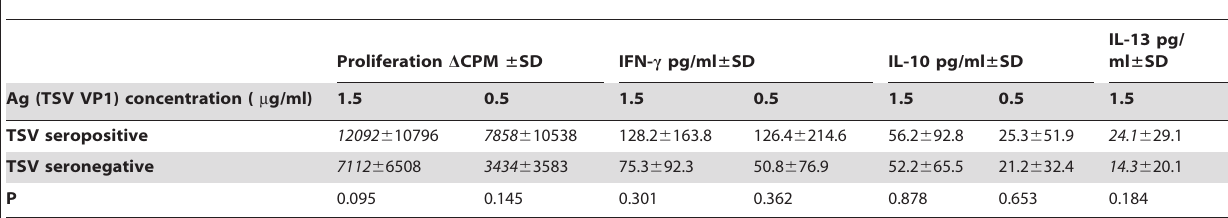
Table 1. Comparison of TSV-specific proliferation and cytokine responses in 30 TSV seropositive and 21 seronegative subjects.